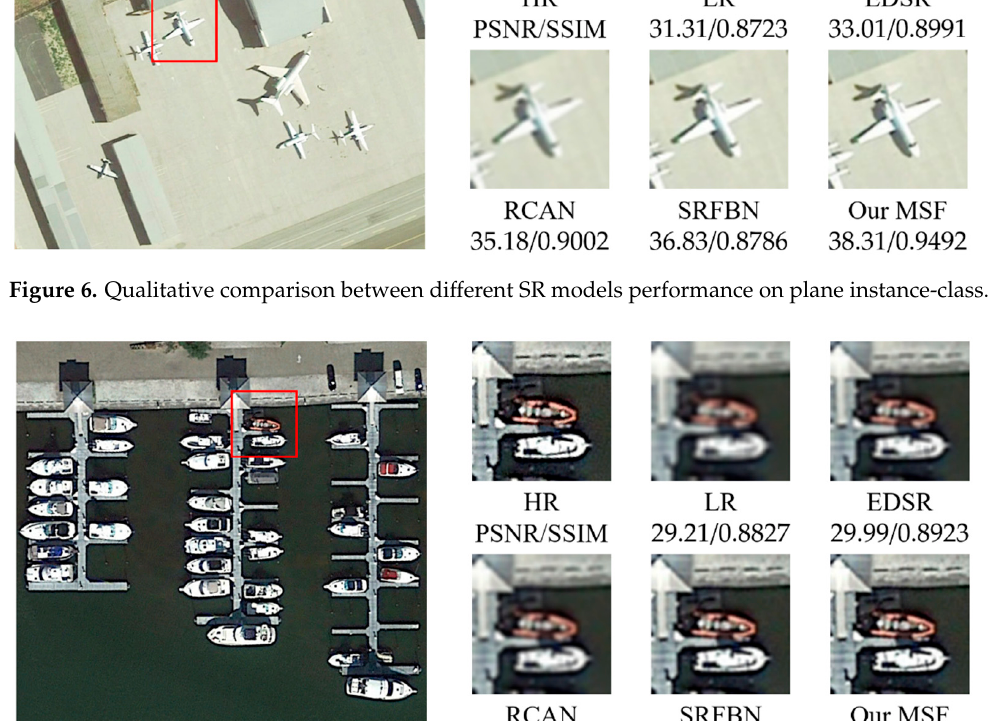
Figure 7. Qualitative comparison between different SR models performance on ship instance-class.